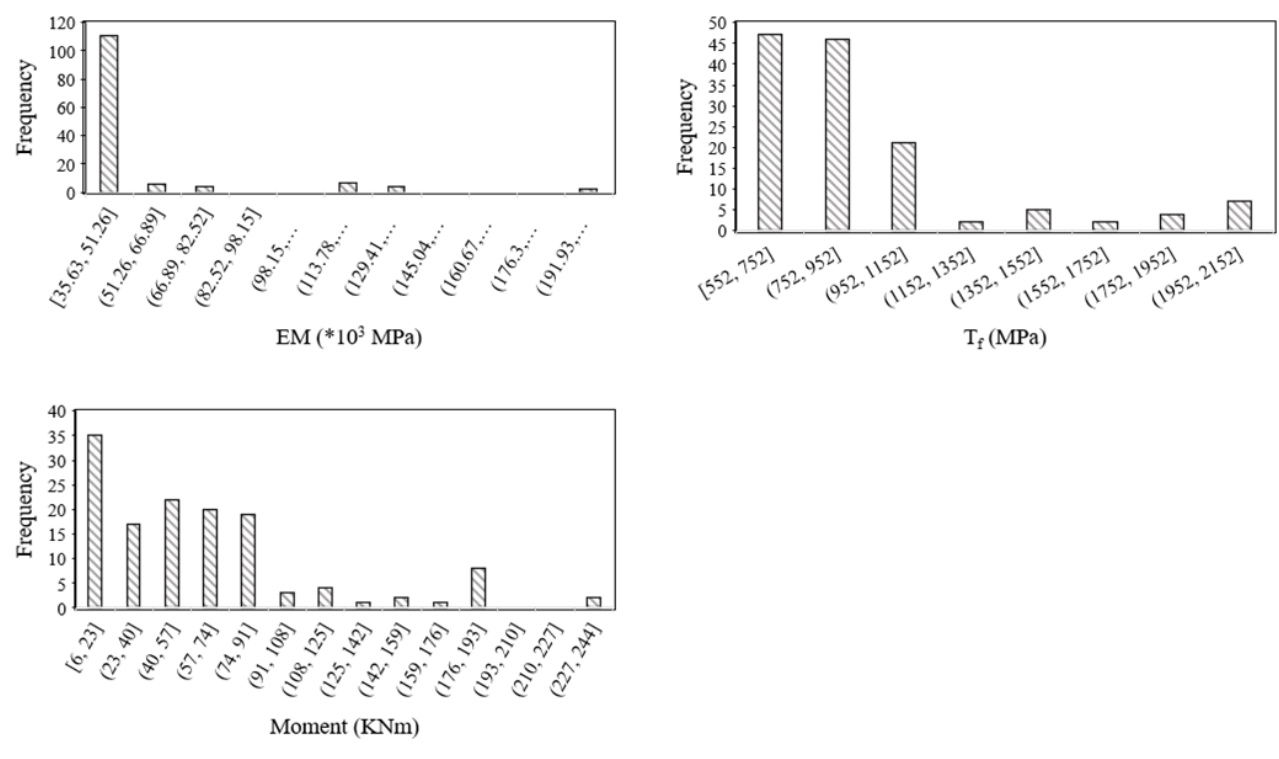
Figure 1. Distribution histograms of the variables ( W , D , f c ’ , As , EM , T f , M ) used in the development of models. Table 2. Descriptive statistics of input and output